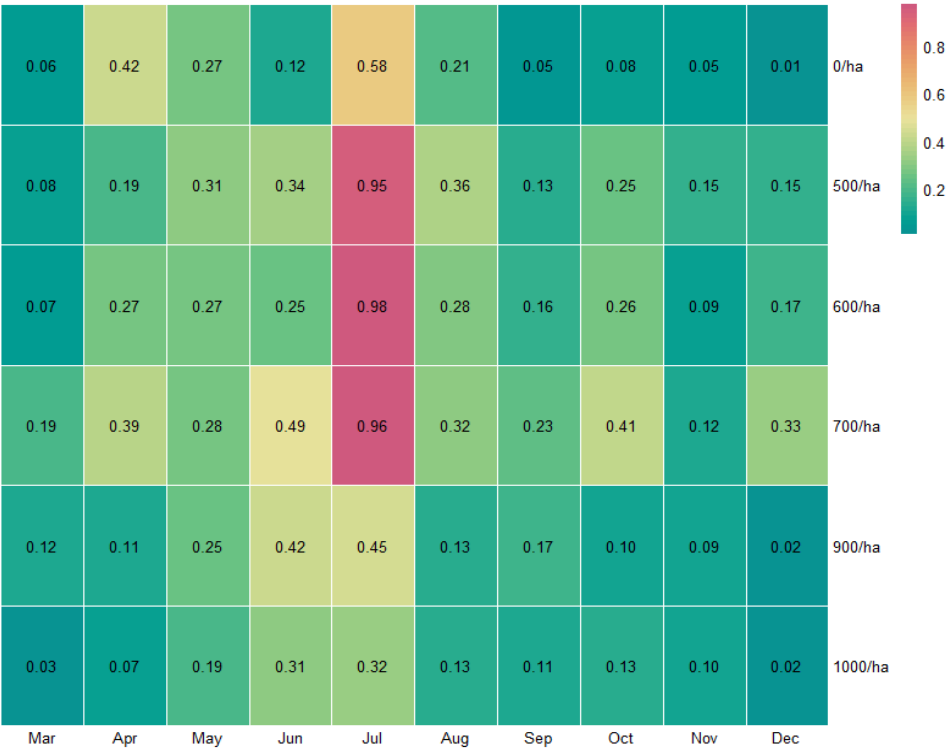
Figure 3. Heatmap of monthly average TNVOC ( μ g/m 3 ) emissions according to forest density. Furthermore, Figure 4, which explains the monthly deviation in TNVOC emissions at the surveyed sites by forest density, shows the largest deviation in monthly